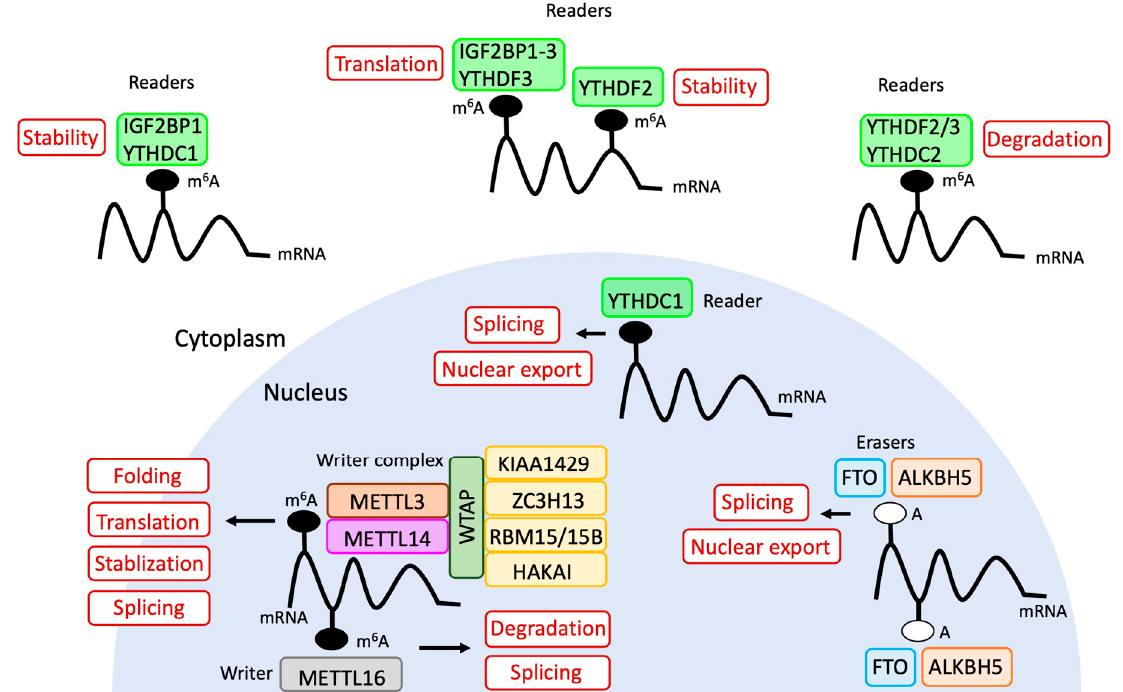
Figure 3. Biological functions of N 6 -methyladenosine. The main writer complex, readers, and erasers are involved in the processes of mRNA metabolism and mediate RNA folding, splicing, stability, transport, and translation.